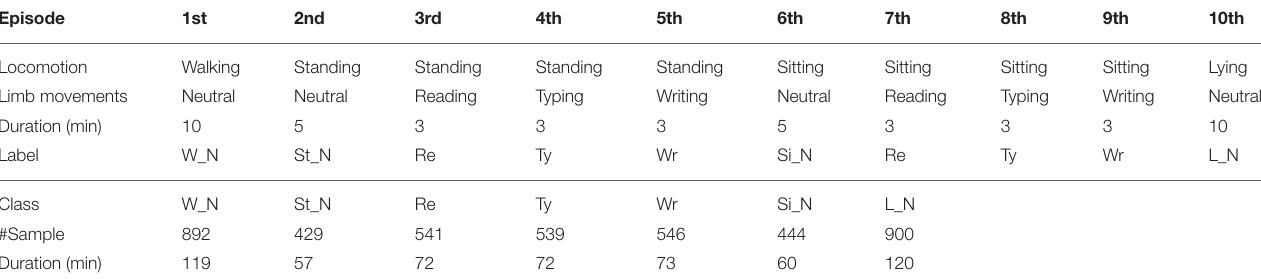
TABLE 2 | The protocol of the experiment (upper) and the samples number for each class